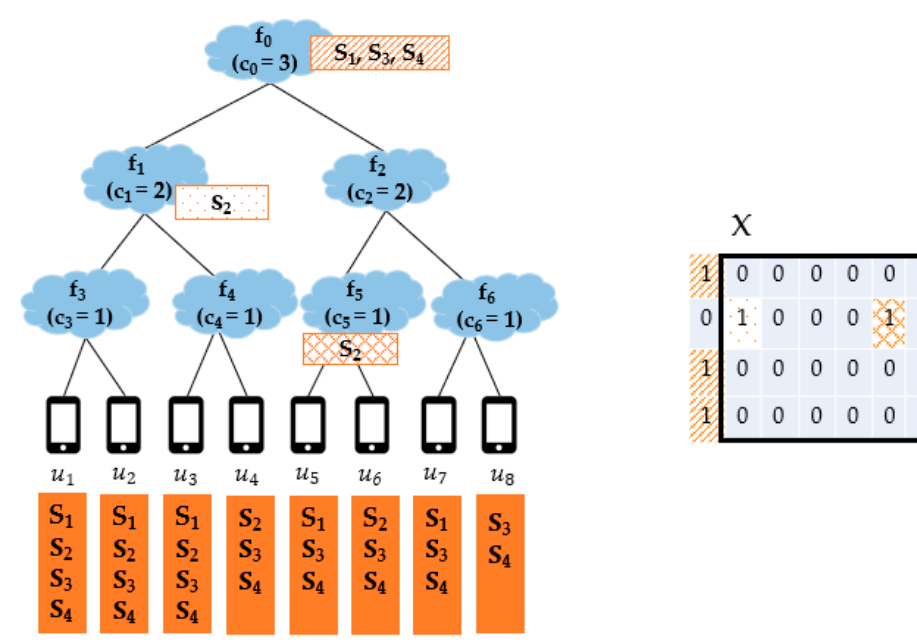
Figure 5. The service provisioning result of the FC-SP mechanism.